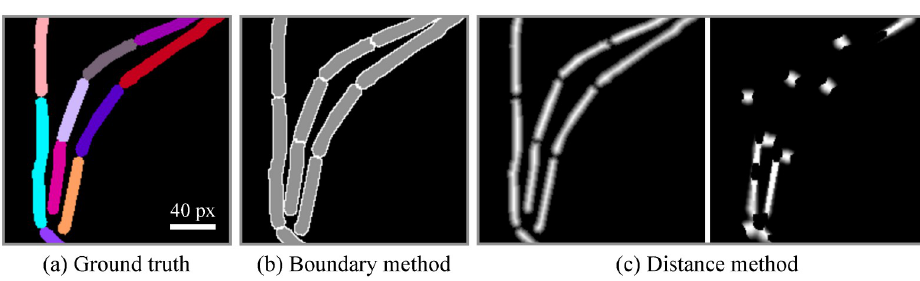
Fig 4. Training data representations of the two microbeSEG methods. From the ground truth (a—instances: color- coded), the boundary representation (b—cell interior: gray, cell boundary: white) and the distance representations (c— distance to background, inverse distance to neighbors) can be computed. A deep learning model is trained to predict either the boundary representation or the distance representations, and the single instances are recovered in the post-